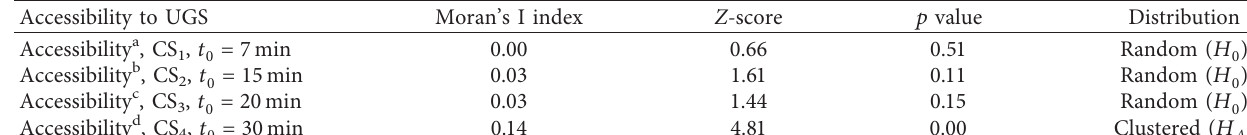
equals 7min, 15min, 20 min, and 30min). 0